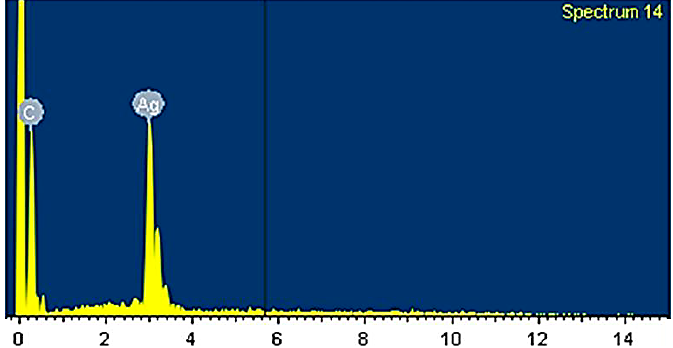
Figure 2. Energy dispersive X-ray collected on PCL/MAA nanofibers containing AgNPs